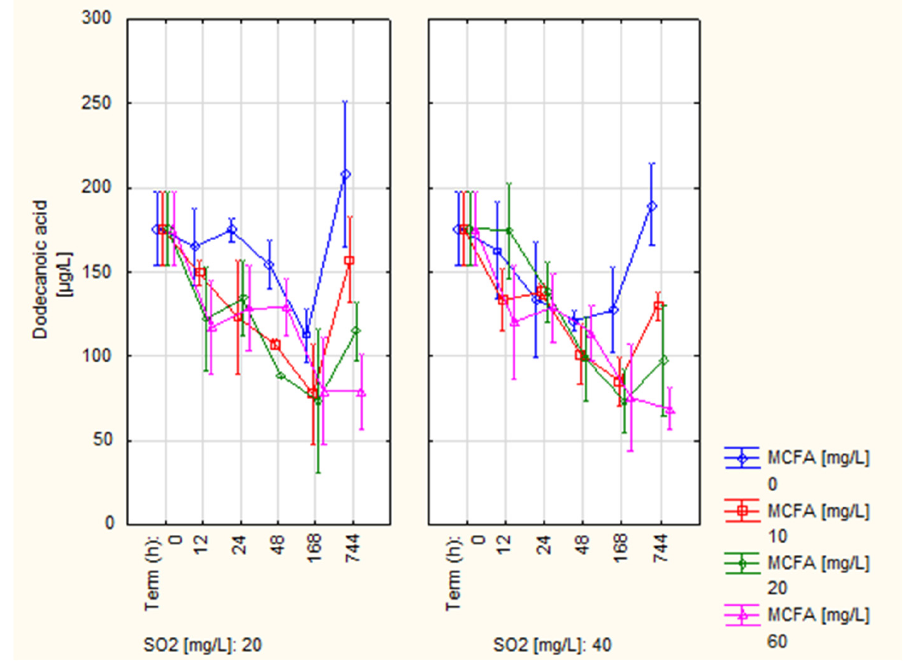
Figure 3. Development of dodecanoic acid content